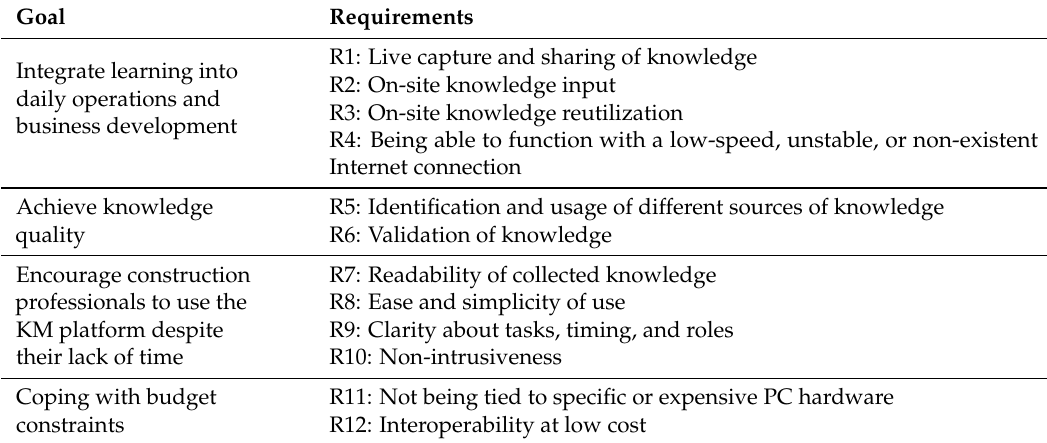
Table 1. Construction SMEs’ requirements for a KM